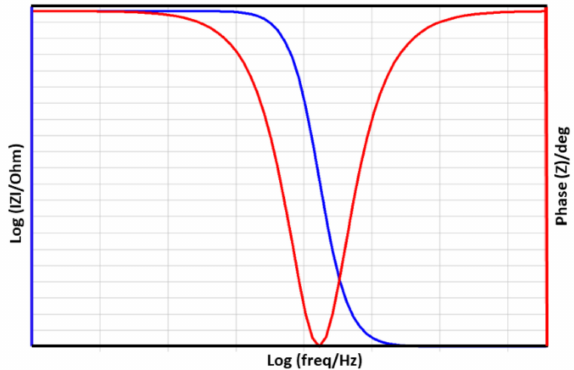
Figure 15. Impedance data represented as Bode plot. In a system with a conductive electrolyte containing the redox couple, as in a VRFB, the different frequency ranges signify various regions dominated by the different